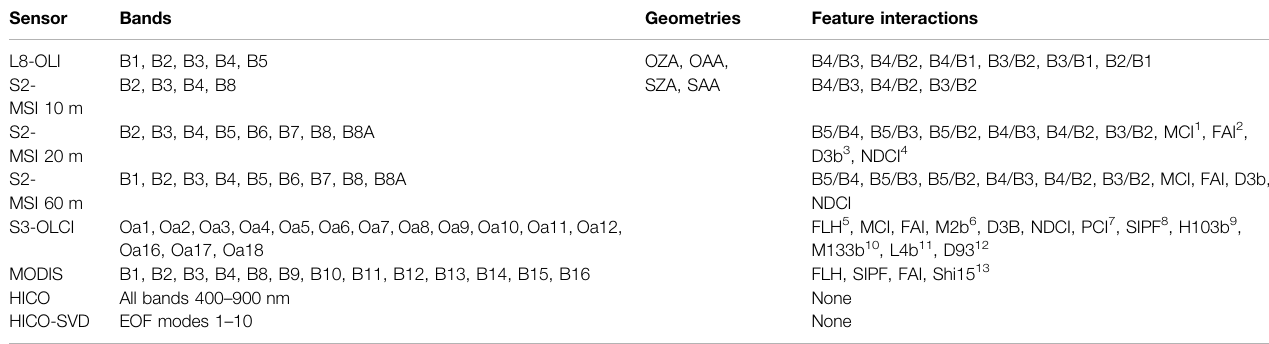
TABLE 1 | Inputs for ML models. Inputs are the same for the four ML models used in this study, except for Sun and sensor geometries, which were only used on TOA models.Referencesfrom1to13(Goweretal.,2008;Hu,2009;Dall ’ OlmoandGitelson,2005;MishraandMishra,2012;Goweretal.,1999;Mosesetal.,2009;Qietal., 2014; Matthews et al., 2012; Hunter et al., 2010; Mishra et al., 2013; Liu et al., 2017; Dekker, 1993; Shi et al.,